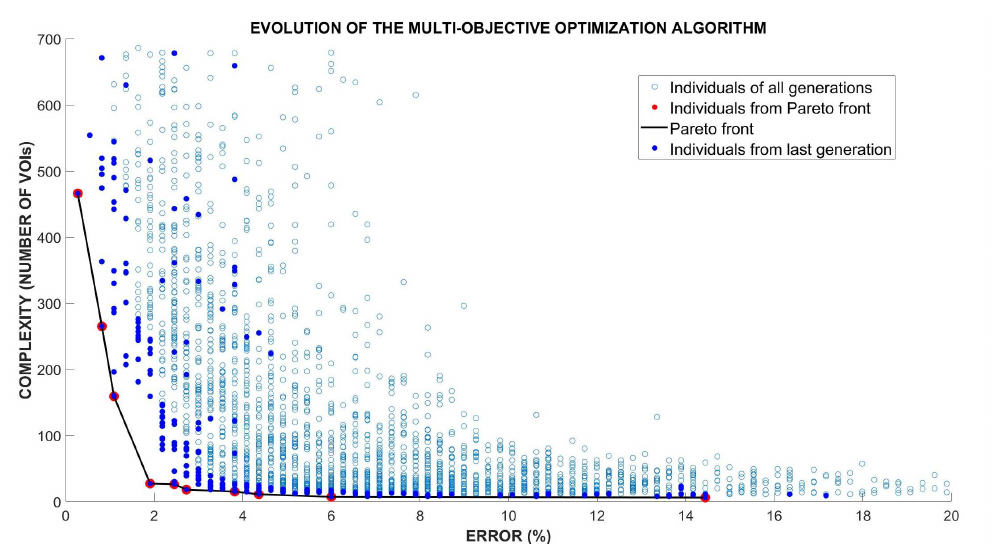
Figure 12. Evolution of all populations of individuals of the MOE algorithm (including the last generation and the Pareto